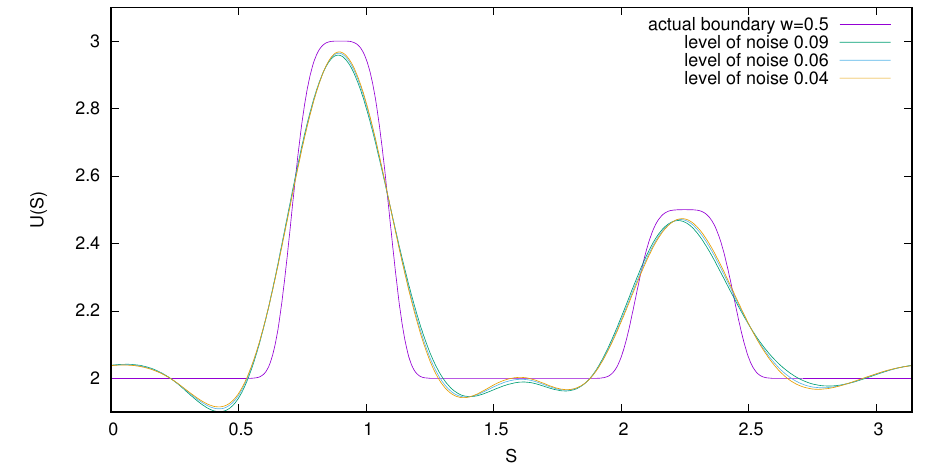
Figure 8. Recovered unknown interior boundary for example 4: effect of